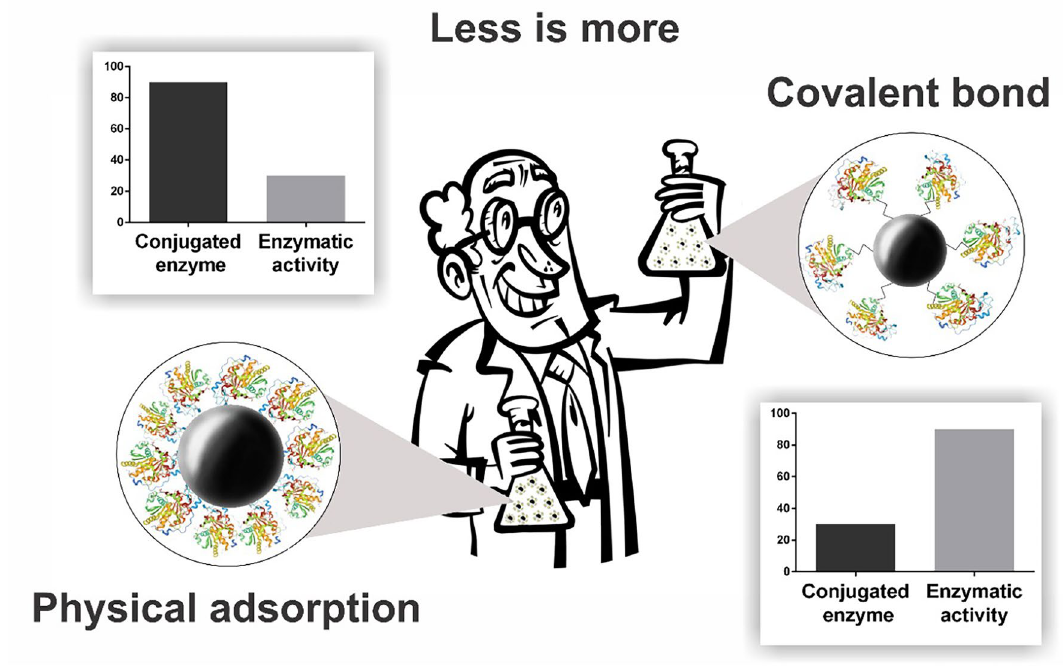
Figure 6. Schematic summary of the immobilization strategies (physical adsorption and covalent coupling).